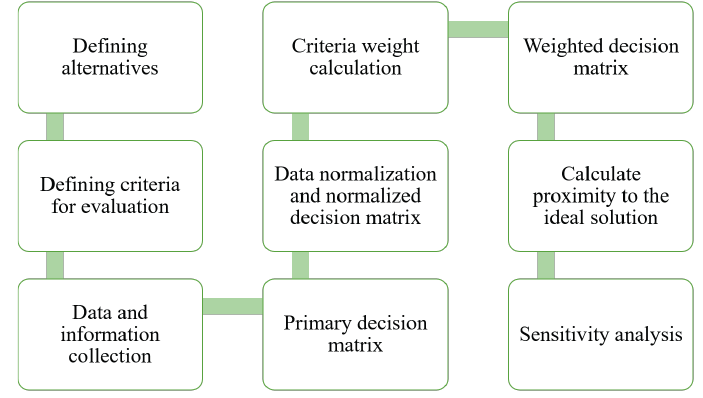
Fig. 3. Calculation stages for TOPSIS MCA